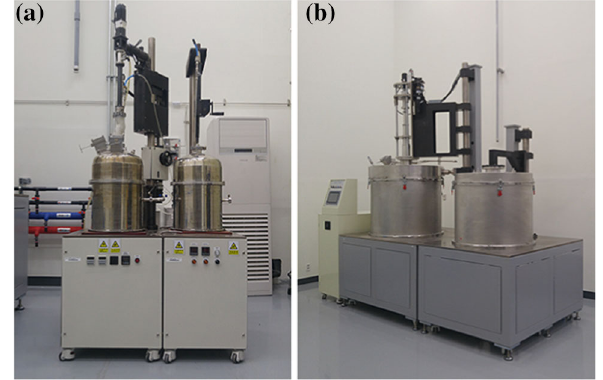
Fig. 1 Two dedicated Kyropoulos growers for the NaI(Tl) crystals. a A small-sized grower for low-background NaI(Tl) R&D and b a full- sized grower for 120 kg size NaI(Tl) crystal production. Both growers have an accompanying setup to facilitate hot crystal annealing